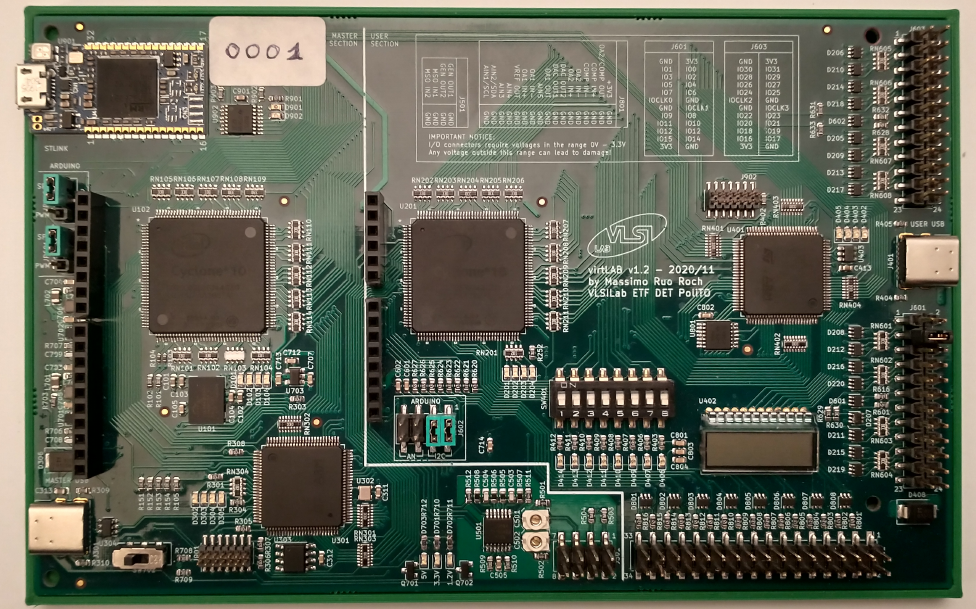
Figure 9. Photograph of the designed